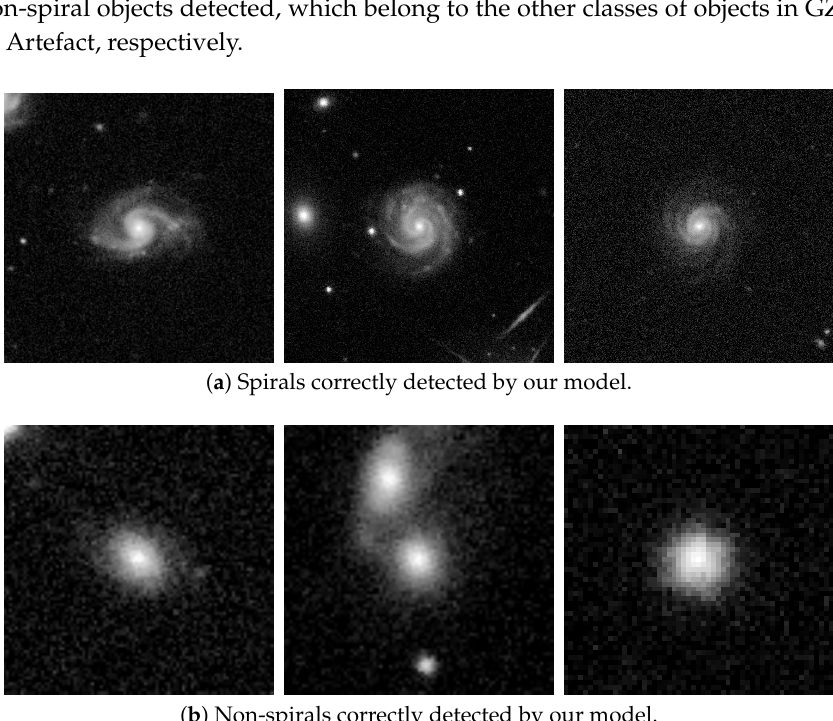
Figure 6. Examples of images that had a high agreement of classification by both, our Random Forest Model and the GZ1 humans. ( a ) shows images of spirals where P SP ≥ 0.90 AND | P SP − F SP | ≤ 0.02. Their SDSS IDs are, respectively, 1237654030325973054, 1237662306733916433, and 1237668298219847857; ( b ) shows images of non-spirals where P SP ≤ 0.10 AND | P SP − F SP | ≤ 0.02. Their SDSS IDs are, respectively, 1237663529721397476, 1237661465447497940, and